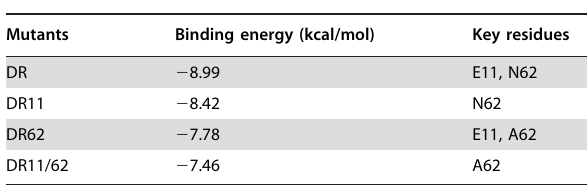
Table 3. The effect of the mutants of HLA-DR on the